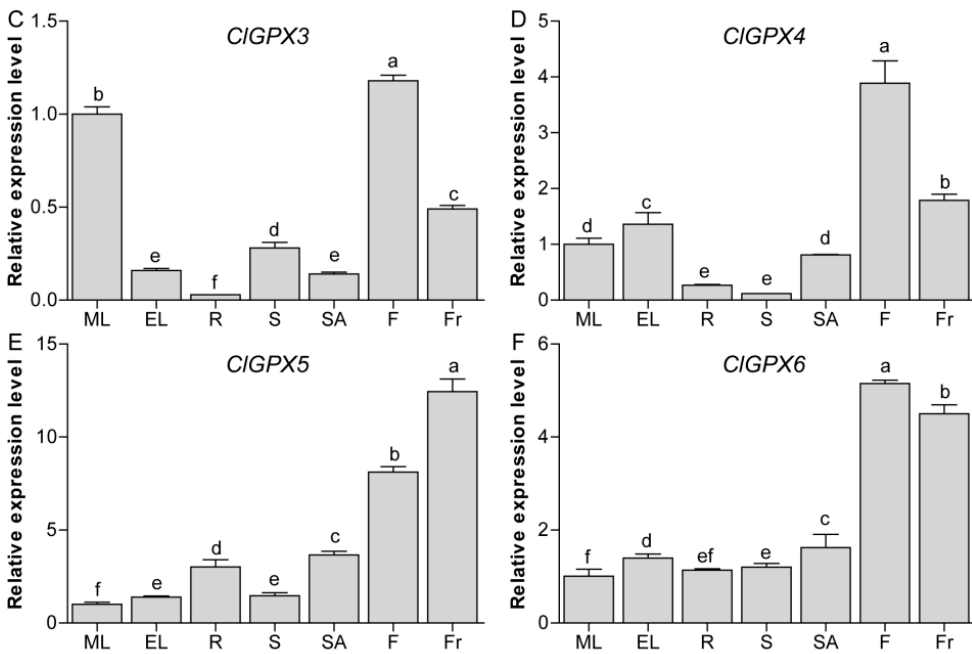
Figure 6. Expression profiles of ClGPX genes across different tissues in watermelon. The amount of ClGPX mRNA was normalized to that of actin . Error bars were SD of three biological replicates. Different letters indicate statistically significant differences (Tukey’s test with a p < 0.05). ML, mature leaves; EL, expanding leaves; R, roots; S, stems; SA, stem apexes; F, flowers; Fr, fruits.